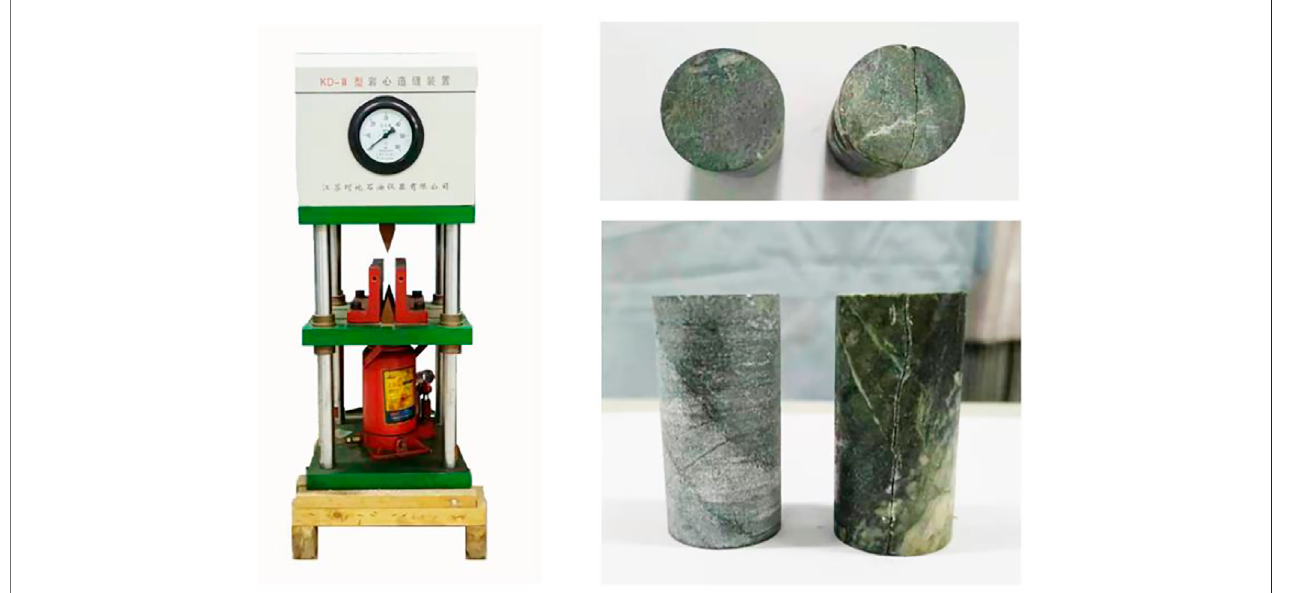
FIGURE 3 | Device for arti fi cially creating fractures and cores before and after